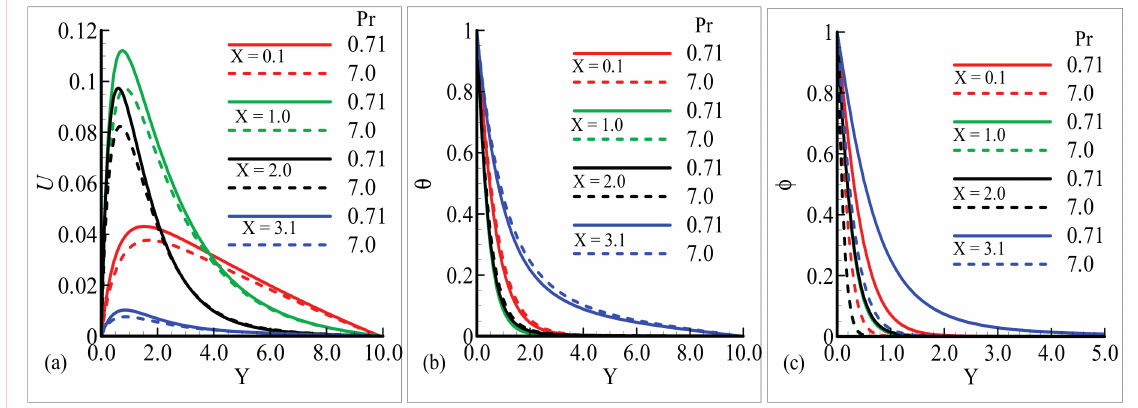
Figure 4. Physical e ff ects on quantities ( a ) U , ( b ) θ , and ( c ) ϕ versus Pr, when Nt = 0.02, Nb = 0.4, SC = 1.0, M = 0.2, Q = 1.0.